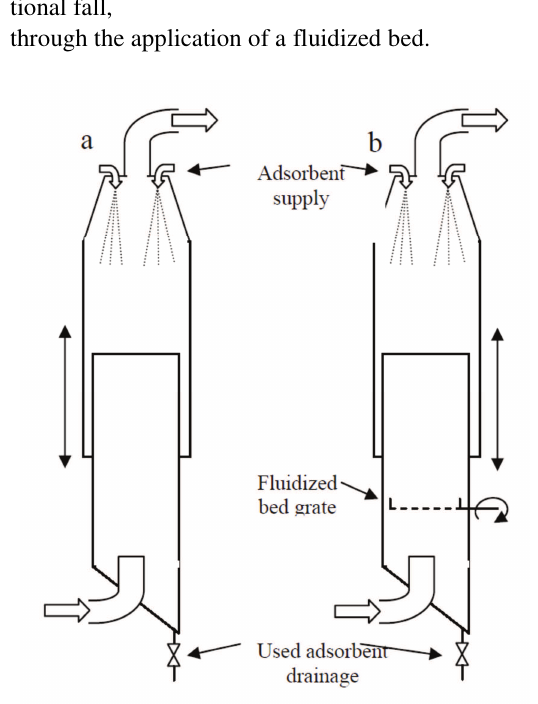
Fig. 1. The concept of the reactor structure: a) counter-current reactor, b) fluidized bed reactor